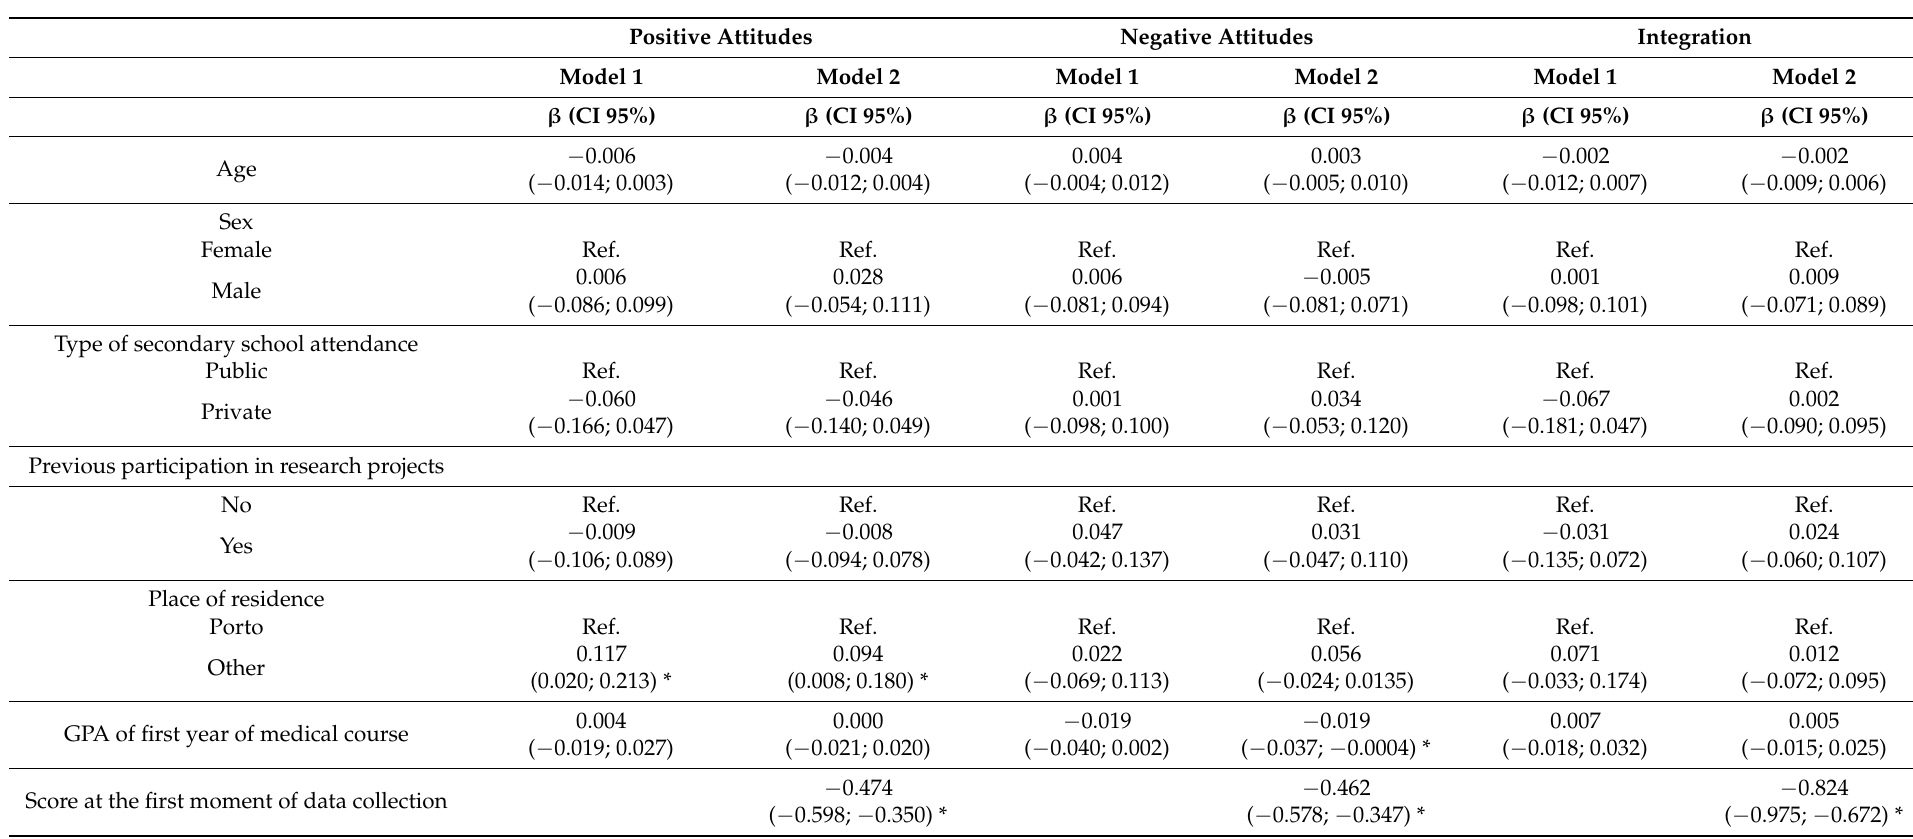
Table 3. Regression models of association between Positive Attitudes, Negative Attitudes, Integration and Age, Sex, Type of secondary school attendance, Previous participation in research projects and GPA of first year of medical course.